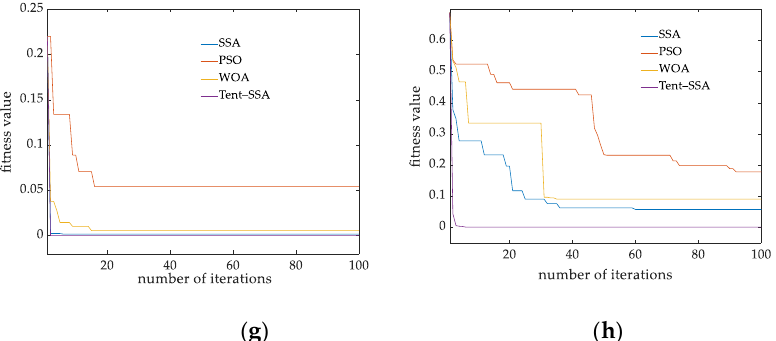
F – F iterative conver- 1 8